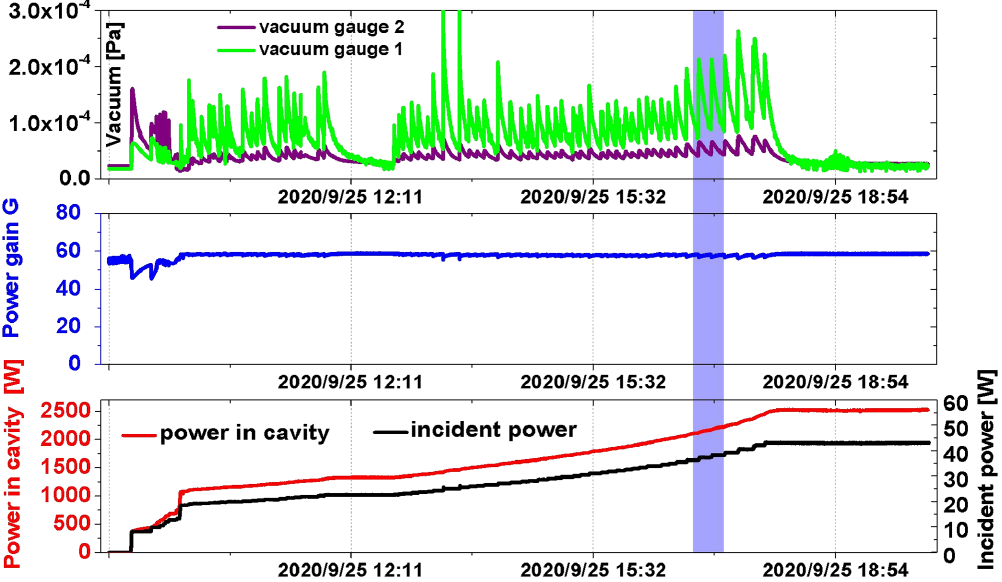
FIG. 23. High-power test results with the left short at z ¼ − 52 cm.